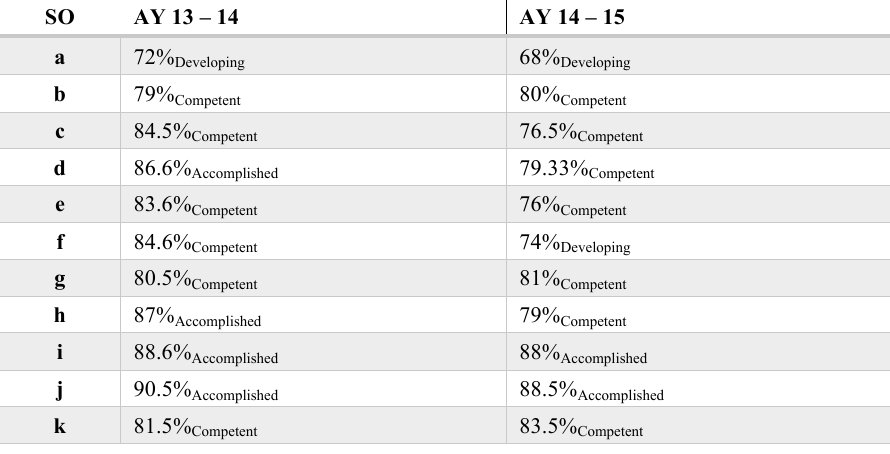
Table 8. Attainment scores for the SOs over two assessment